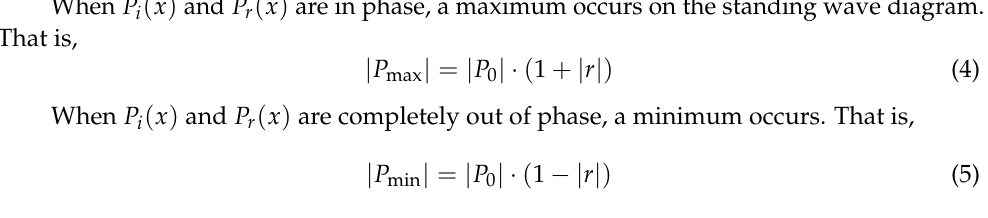
Figure 3. Schematic of acoustic impedance tube detection. When )(xP and )(xP are in phase, a maximum occurs on the standing wave i r diagram. That is,